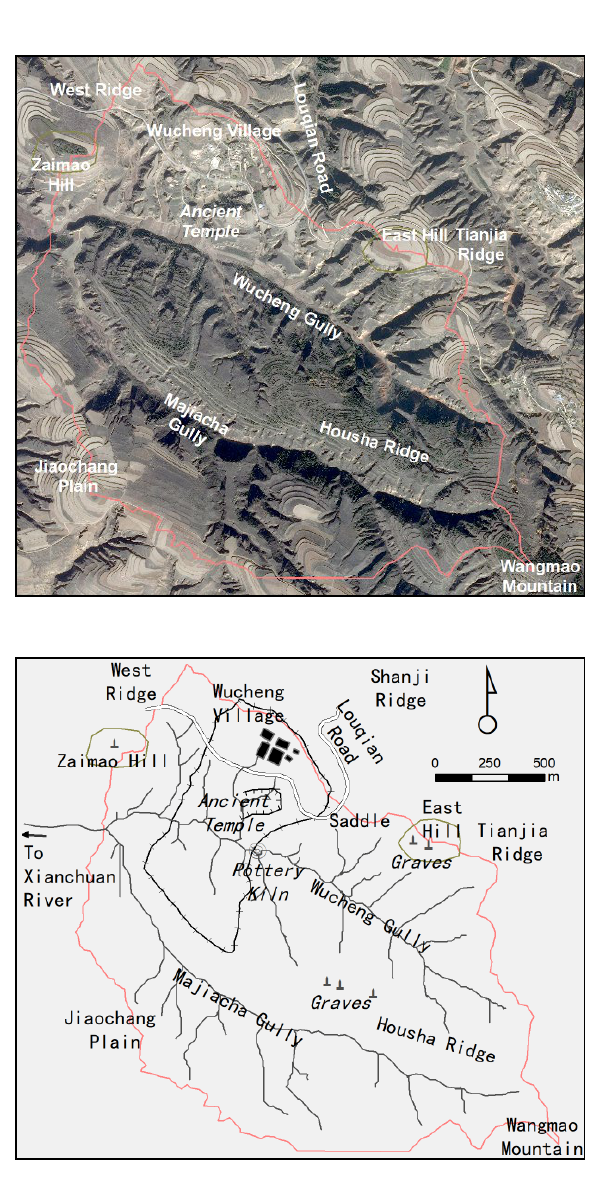
Figure 2. Archaeological Distribution (Wang, 2016). The scale is same. Above is the image and area (red line is the catchment boundary); below is the distribution of the Remains and gullies (black line in the upper-middle is the boundary of the